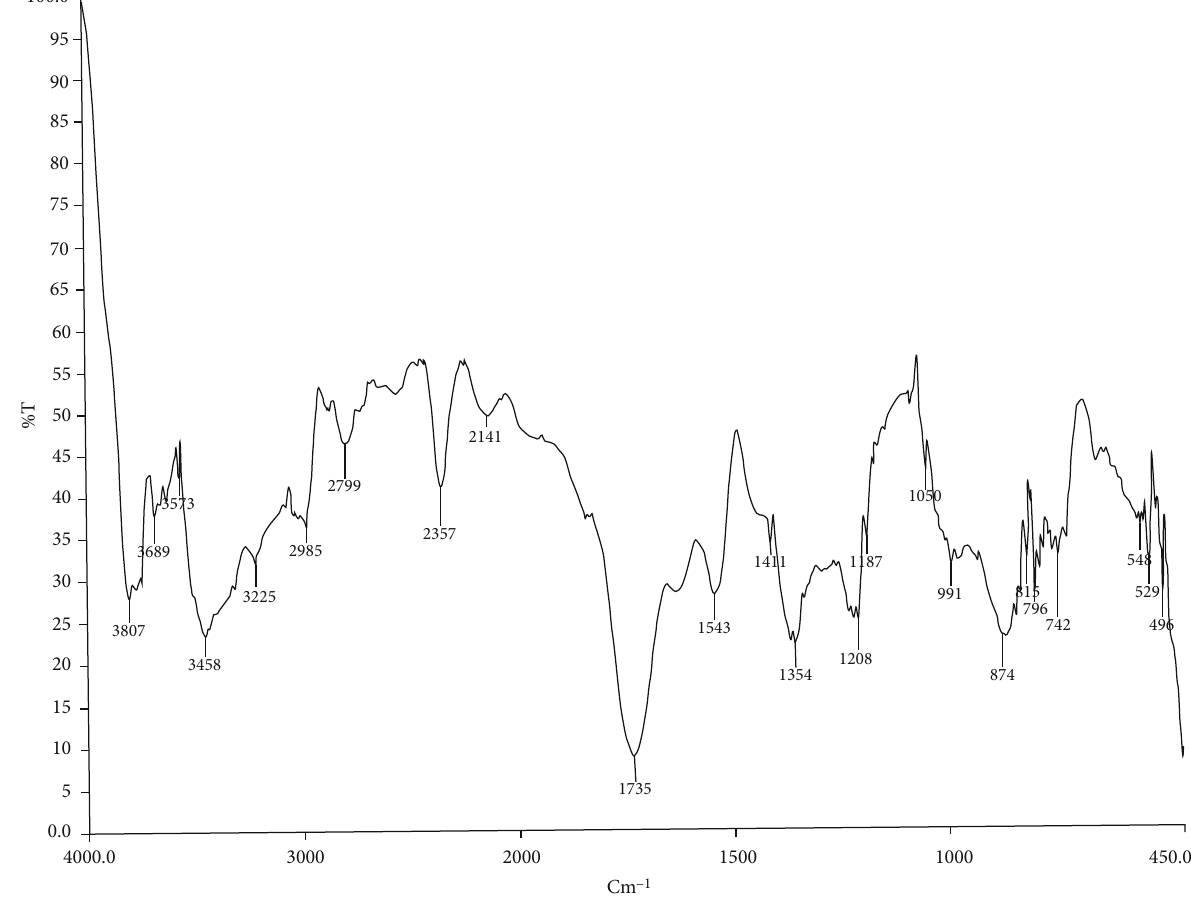
Figure 9: FTIR analysis of SA-Ag-NP-incorporated chitosan biomaterials.